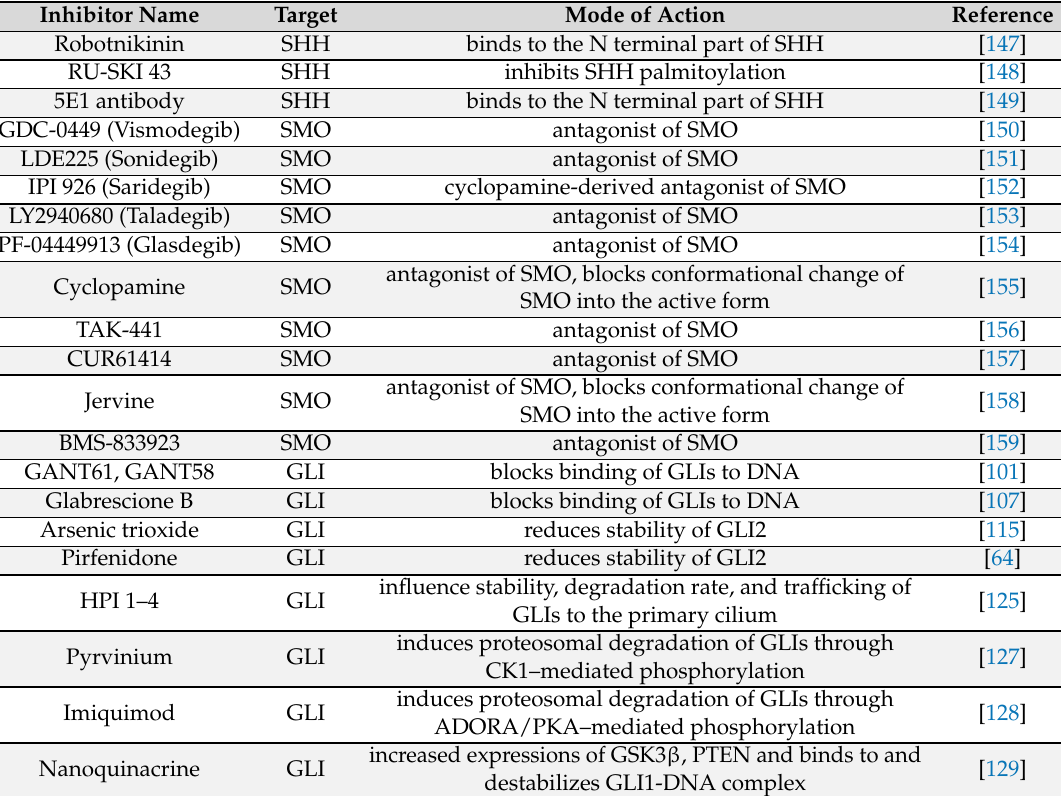
Table 1. List of Hh pathway